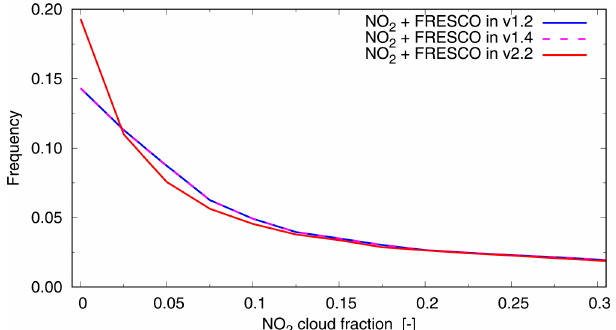
Figure 8. Frequency distribution of the cloud fraction in the NO 2 fit window from orbit 03707 on 1 July 2018, considering only ocean and land ground pixels that are free of snow/ice, with a bin size of 0.0025 and the first bin centred around 0.0, zooming in on the lower cloud fraction. Shown are curves from the NO 2 cloud fraction using the FRESCO cloud pressure in the public v1.2 data (solid blue lines), its implementation in the v1.4 framework with the use of level-1b v1.0 spectra (dashed magenta line), and with level-1b v2.0, i.e. from DDS-2 (solid red line). Note that the v1.2 and v1.4 lines overlap in the figure: the difference between these two is less than